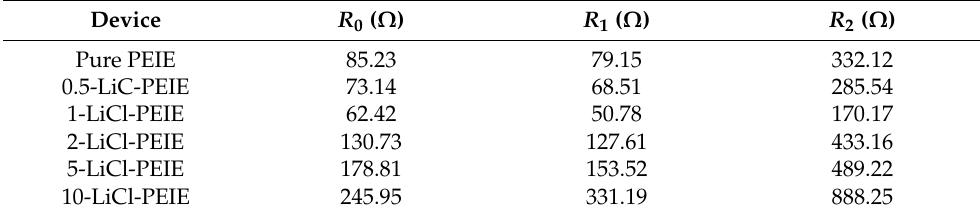
Figure 2. ( a ) I–V curves of the device with the structure of ITO/PEIE (X-LiCl/PEIE)/P3HT:PCBM/BCP/Ag. ( b ) EIS of P3HT:PCBM-based OSCs with different LiCl/PEIE interfacial layers. Table 2. EIS of OSCs based on different ETLs.